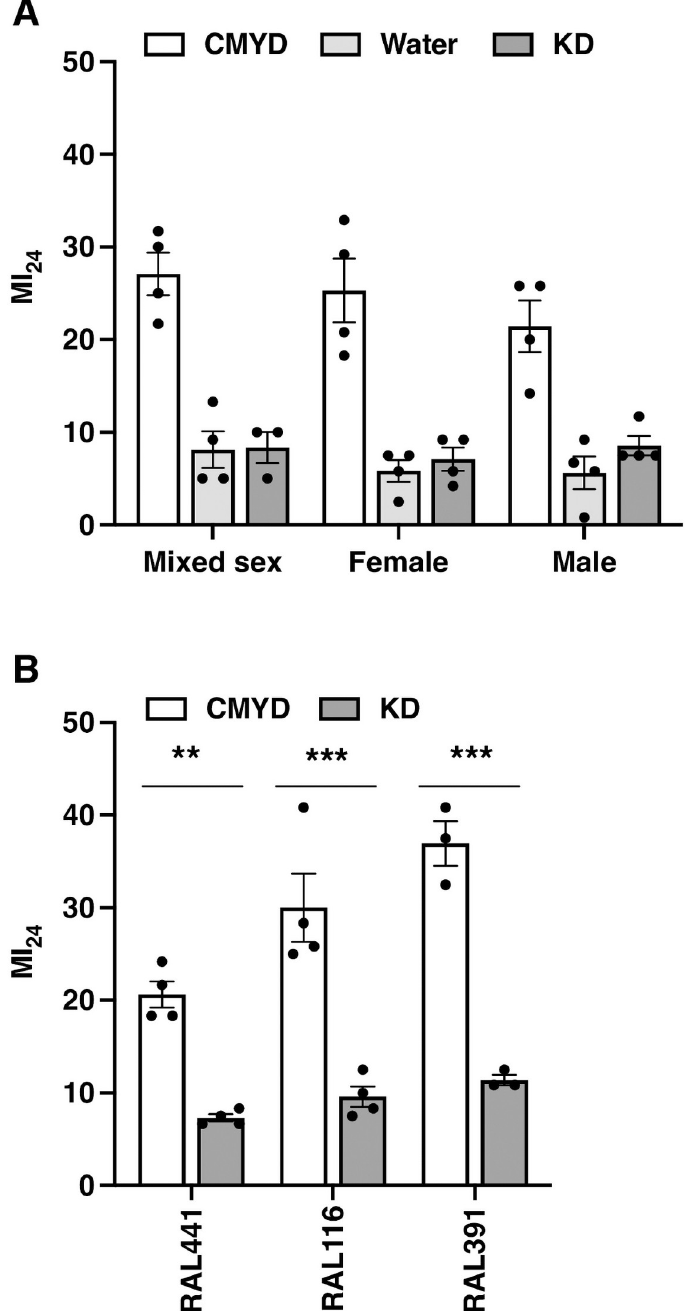
Fig 2. The beneficial effect of KD on early mortality after TBI is equivalent in females and males and is conserved in different genetic backgrounds. (A) MI 24 values were determined for 0–7 day old female, male, and mix sex w 1118 flies fed solid CMYD, water, or 0.3 cal/200 μ l KD. The MI 24 represents the percent mortality of injured flies minus the percent mortality of uninjured flies 24 h following TBI. (B) MI 24 values were determined for 0–7 day old, mixed sex fly lines (RAL441, RAL116, and RAL391) from the DGRP fed 0.3 cal/200 μ l CMYD or KD following TBI [34]. Dots indicate biological replicates of 60 flies, bars indicate averages, and error bars indicate the SEM. Significance was determined using ordinary one-way ANOVA with Dunnett’s Multiple Comparison test. �� p < 0.01 and ��� p < 0.001.